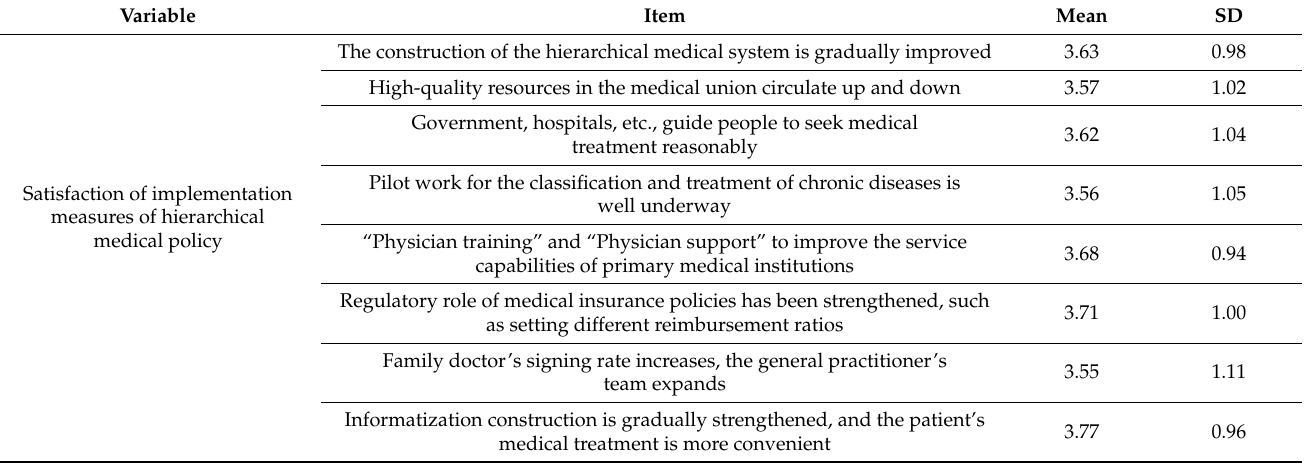
Table 9. Statistics on the satisfaction of the implementation measures of the hierarchical medical